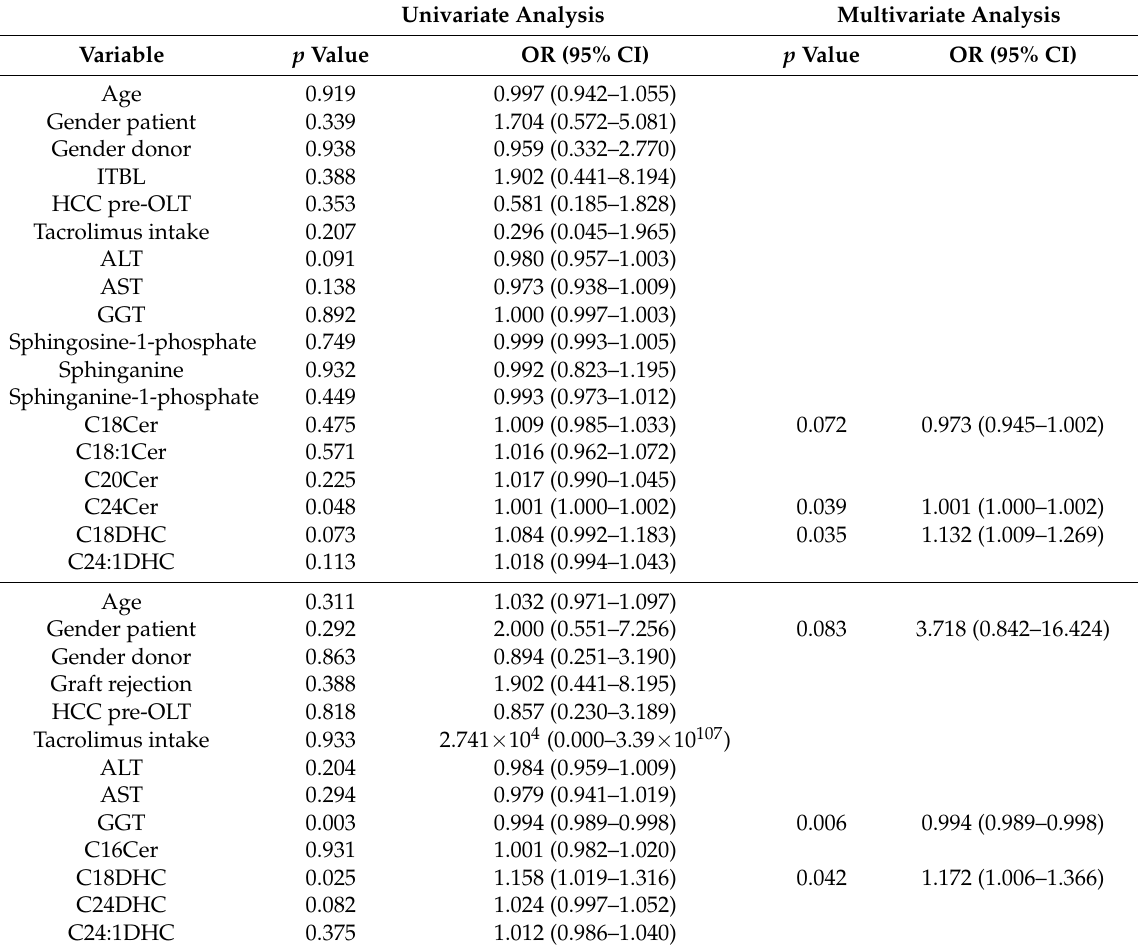
Table 3. Multivariate analyses for history of liver graft rejection (A) and ischemic type biliary lesions (B). Univariate Analysis Multivariate